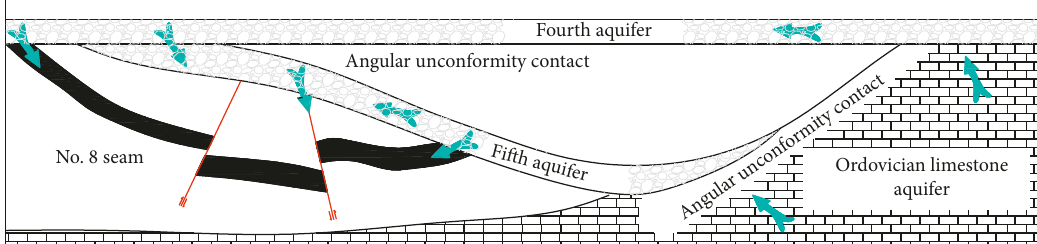
Figure 3: The relationship between the aquifers.